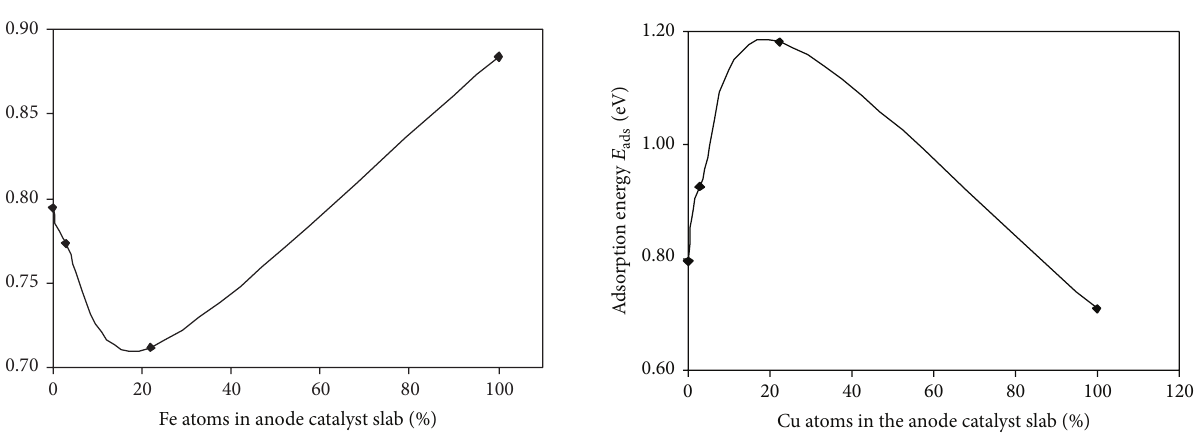
Figure 6: DFT calculated adsorption energies for water on the surface of Ni/Cu alloy slabs having various compositions (0% Cu, 2.8% Cu, 22.2% Cu, and 100%